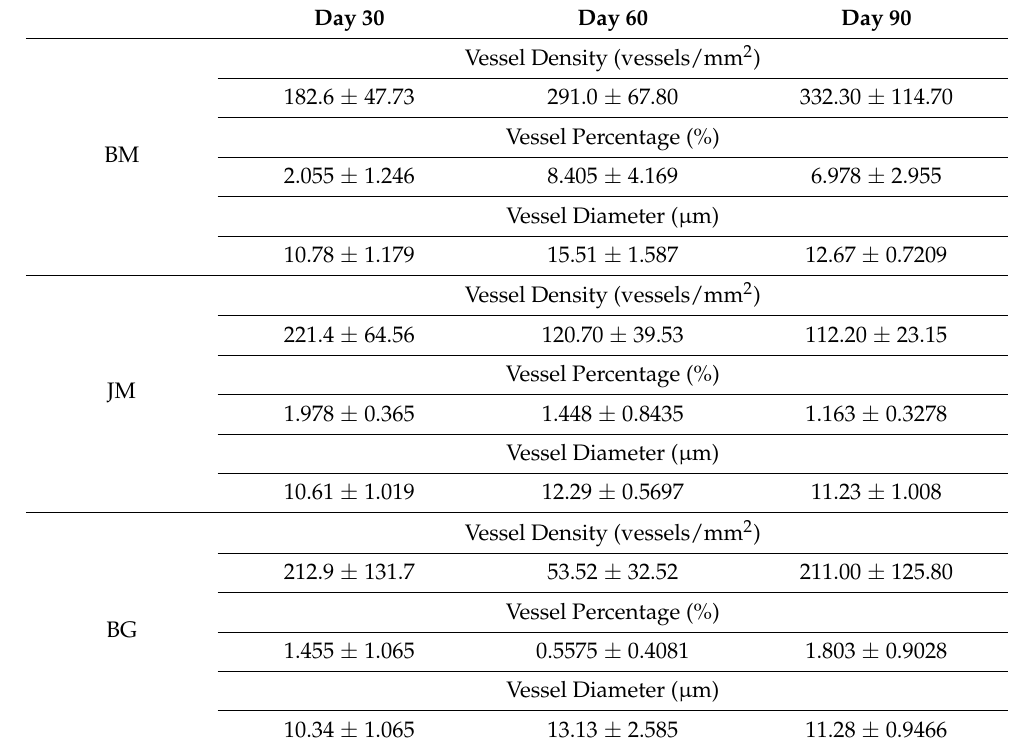
Table 11. Histomorphometrical results of the membrane vascularization. (BM: native bovine mem- brane, JM: Jason ® membrane, BG; Bio-Gide ®